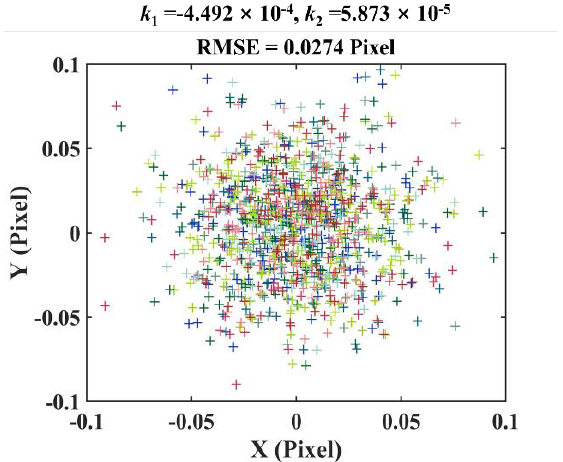
Figure 4. Re−projection errors of the telecentric camera. Figure 4. Re − projection errors of the telecentric